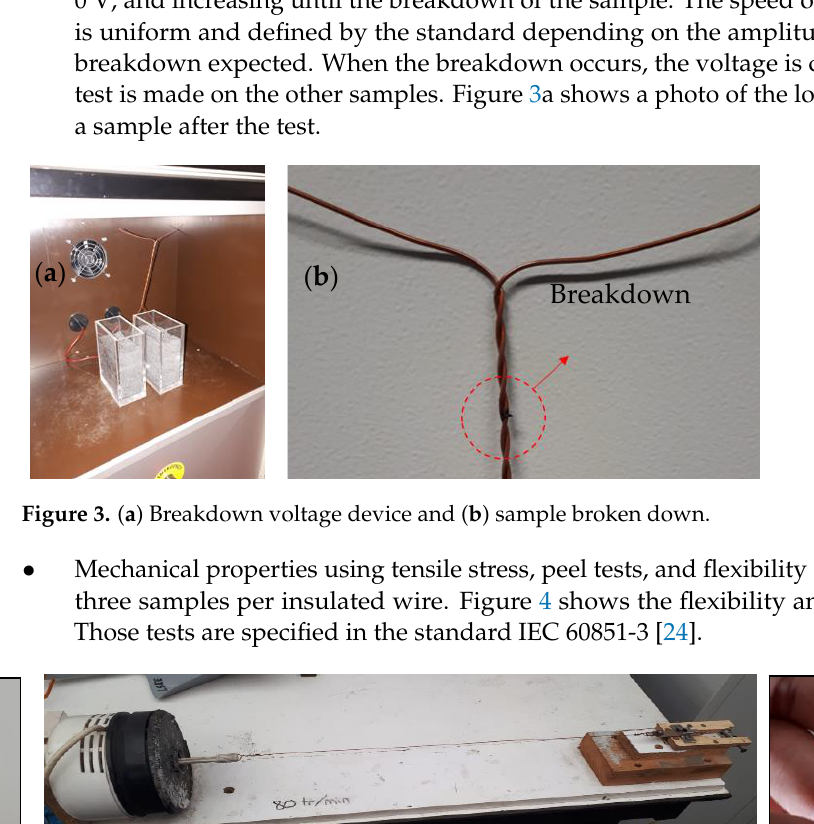
Figure 3. ( a ) Breakdown voltage device and ( b ) sample broken down.